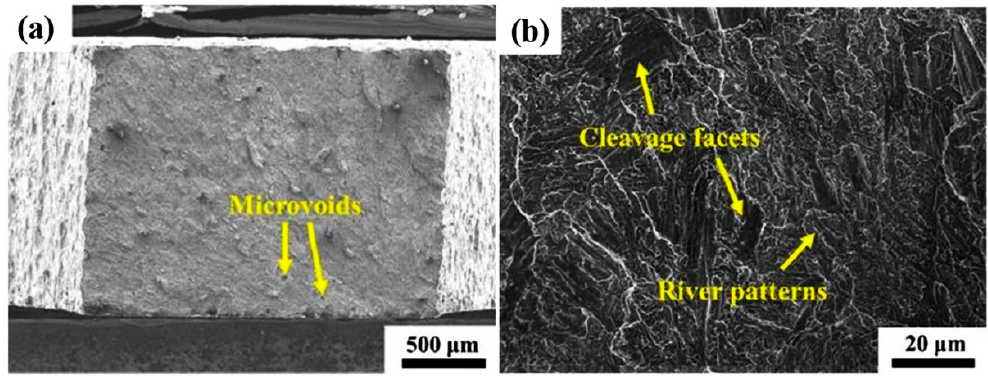
Figure 12. Fracture surface of the tensile samples ( a , b ) overview and magnification image of Ti-2%HA sample [4].